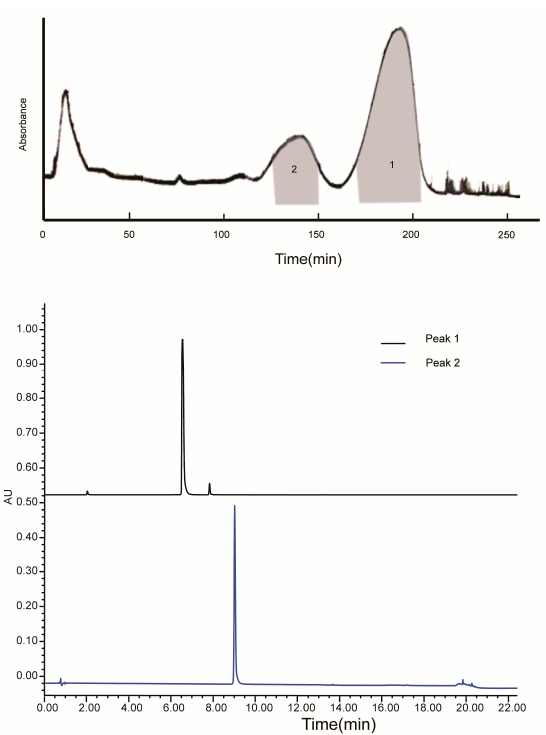
Figure 4. HSCCC chromatogram of Fr.1 and HPLC chromatogram of the two HSCCC fractions (Peak 1: